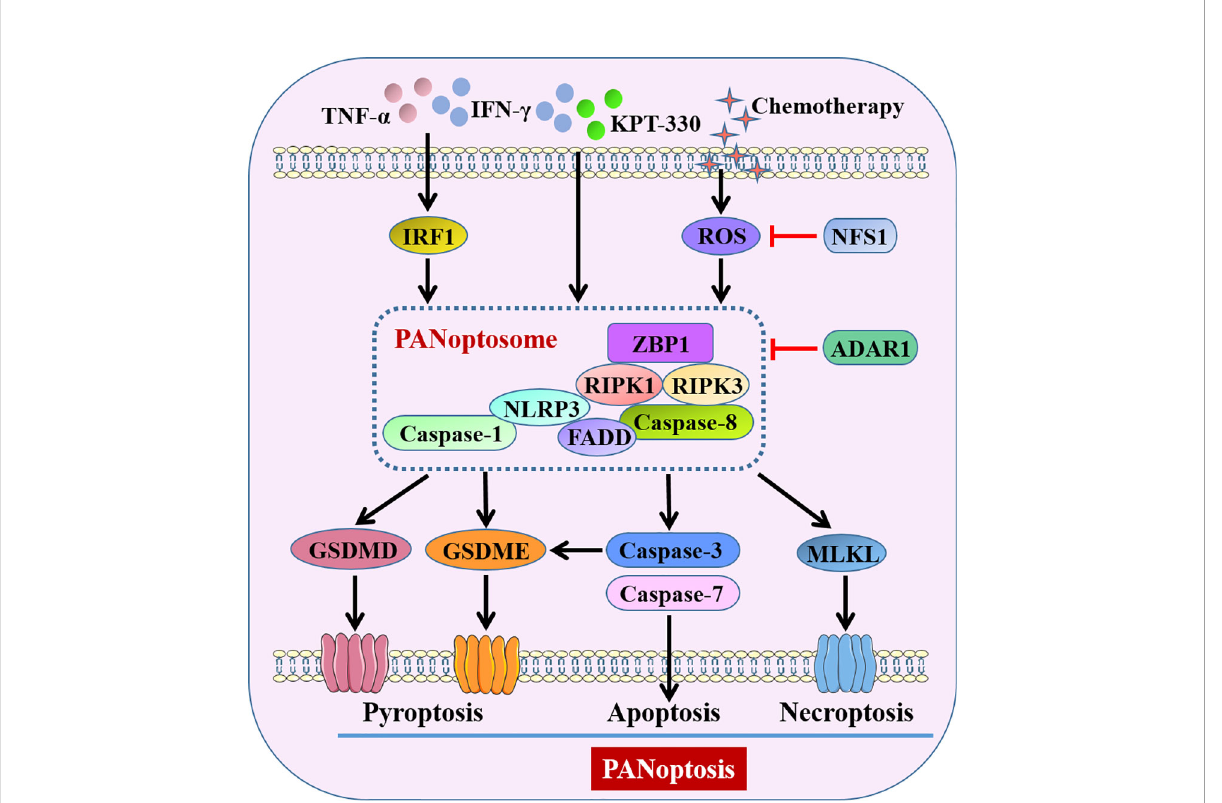
FIGURE 4 Pyroptosis-related PANoptosis in intestine. IFN- g combined with TNF- a or KPT-330, and chemotherapy-induced ROS activate PANoptosome to trigger GSDMs-mediated pyroptosis, caspase-3/7-mediated apoptosis and MLKL-mediated necroptosis, conceptualizing as PANoptosis. ADAR1 and decreased ROS by NFS1 suppress PANoptosis through intervention of PANoptosome. KPT-330, a nuclear export inhibitor; NFS1, cysteine desulfurase; ADAR1, adenosine deaminase acting on RNA 1; ZBP1, Z-DNA binding protein 1; RIPK, receptor-interacting protein kinase; MLKL, mixed lineage kinase domain-like